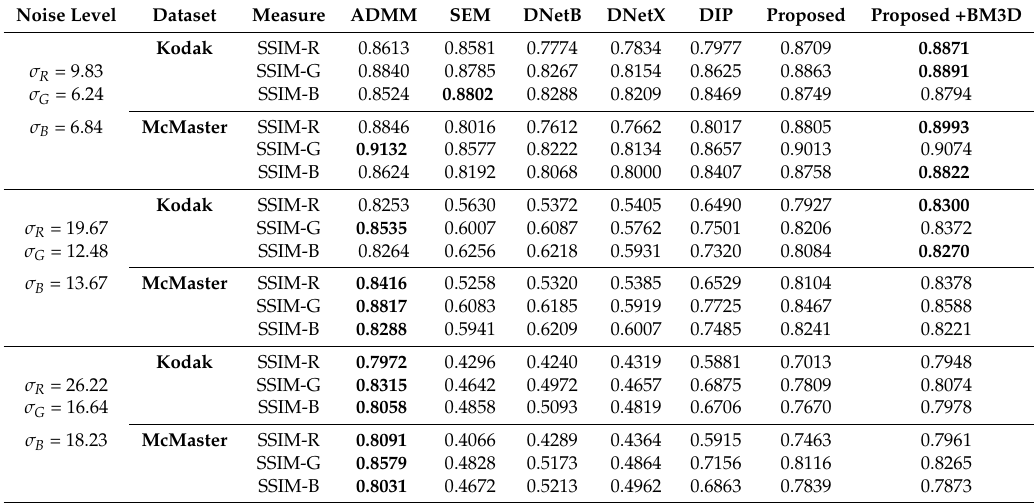
Table 3. Comparison of the SSIM values among the various demosaicing methods on the Kodak and the McMaster image